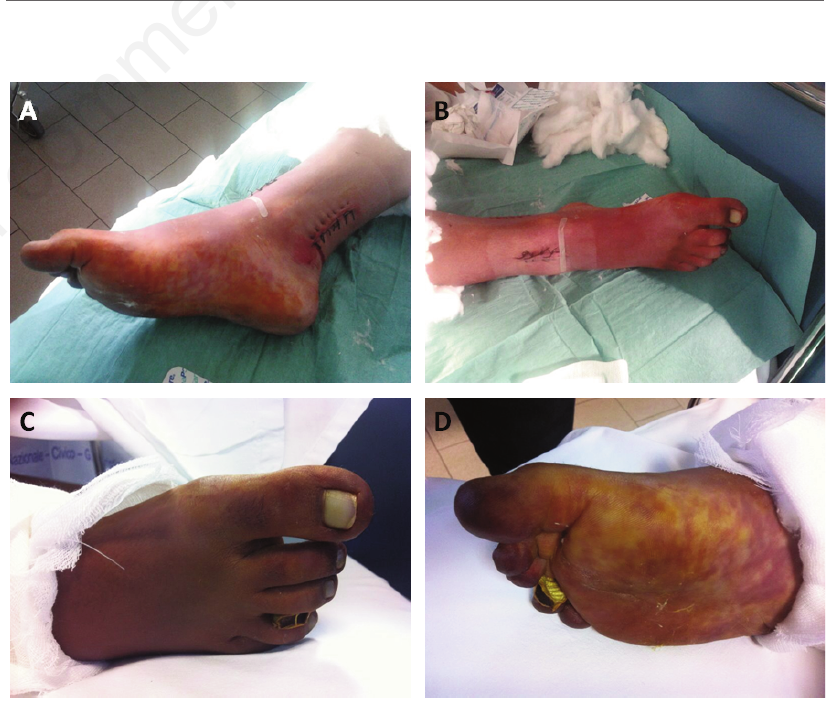
Figure 2. A,B) after the second thromboembolectomy clinical status of the feet suggested a possible recovery of the vascular status and a reversible damage. C) the ischemic